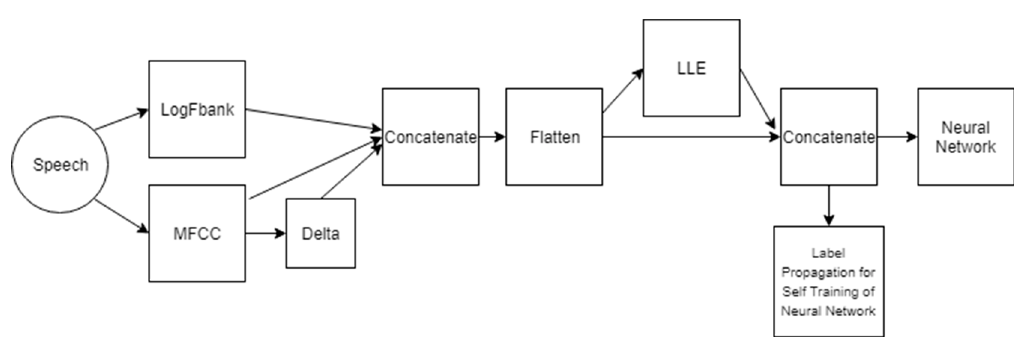
Figure 2. Proposed system model.